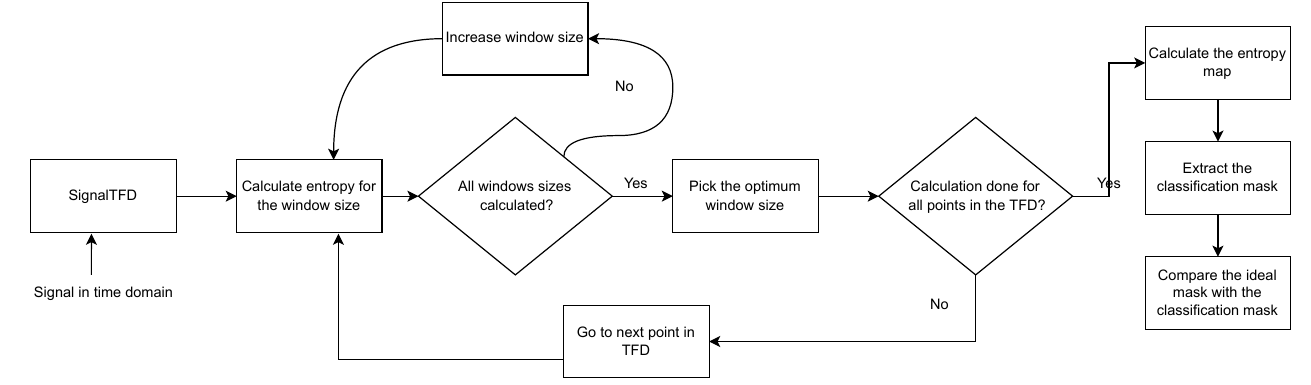
Figure 4. Flowchart of the 2DLEM